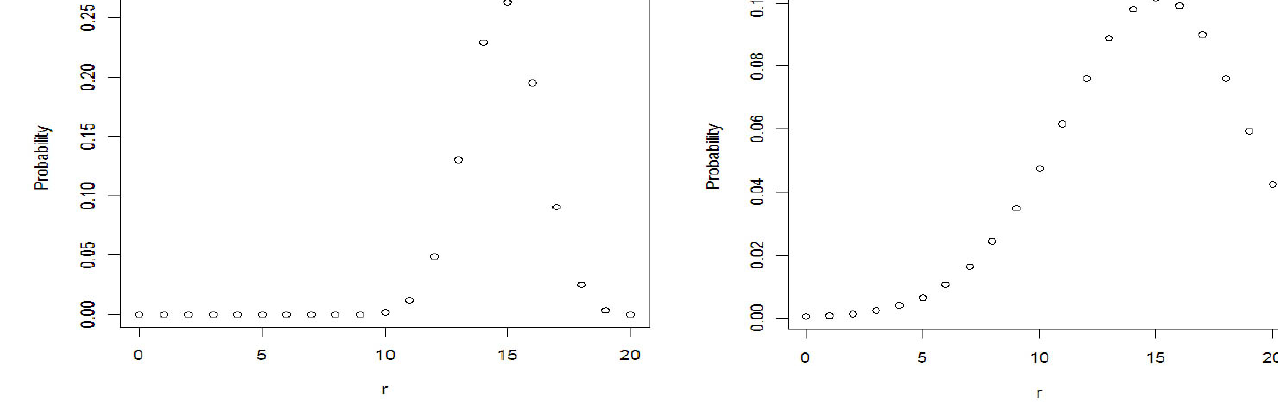
Fig. 4. Exact distribution with p = 30 and L = 20 . Fig. 5. Poisson approximation with p = 30 and L = 20